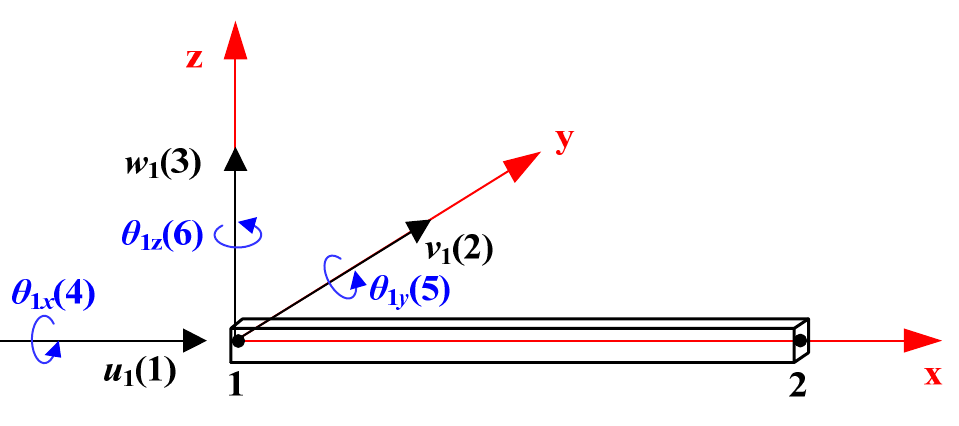
Figure 4. Node displacement and DOF number of beam element.